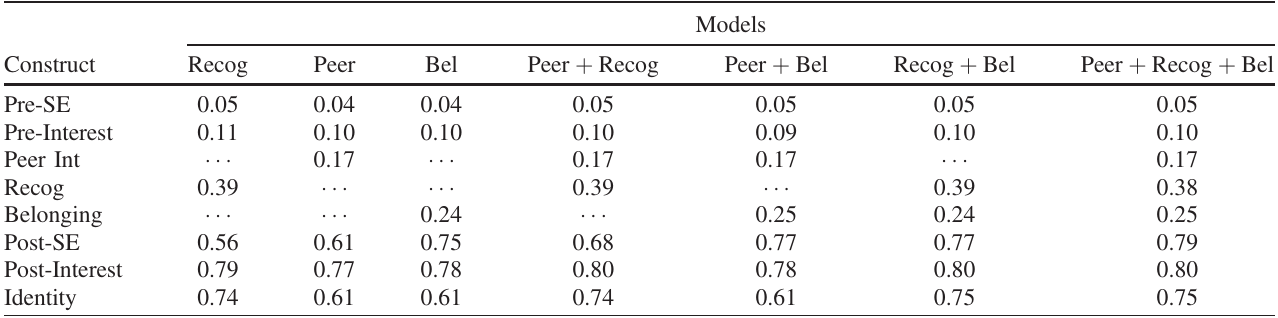
TABLE VI. Coefficient of determination ( R 2 ) for various constructs in different models for impact of the perception of learning environment. All R 2 values are significant and p values < 0 . 001 .